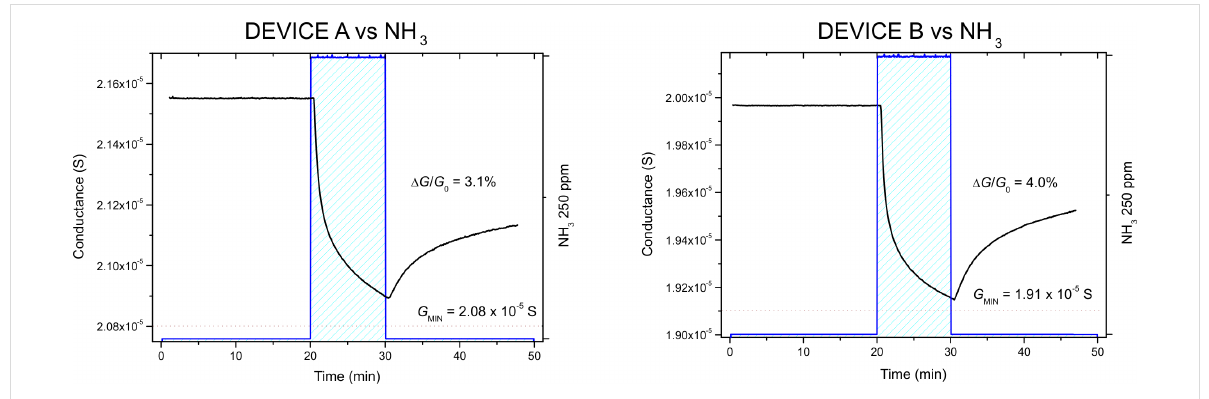
Figure 4: Dynamic response of devices A (left) and B (right) during the exposure to 250 ppm of NH 3 .